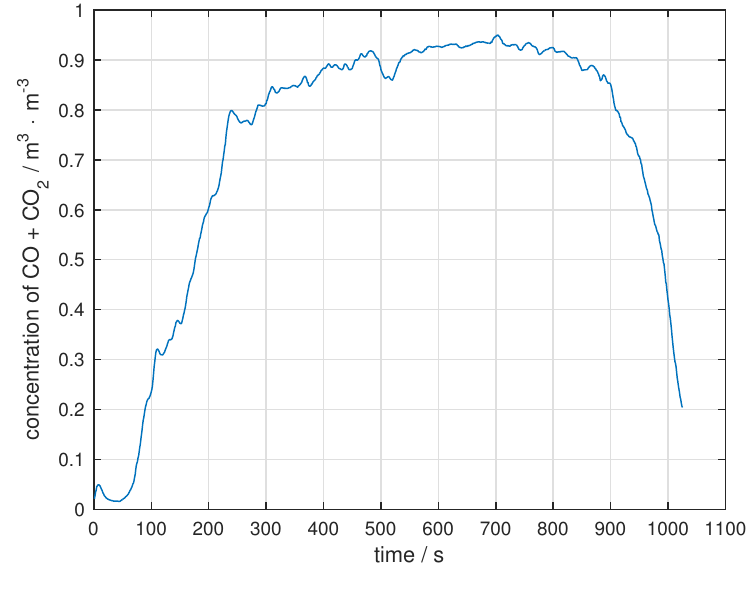
Figure 2. The change of CO and CO 2